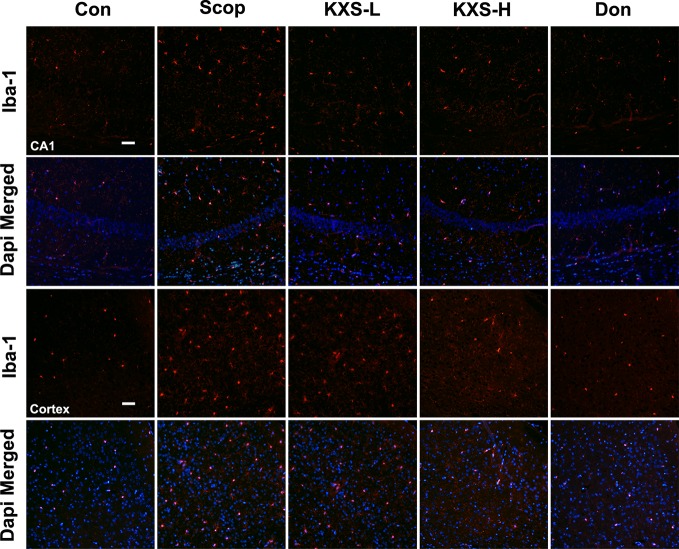
Kai-Xin-San (KXS) attenuates microglia activation in scopolamine (SCOP)-induced mice. Immunofluorescence analysis in the hippocampus (CA1) and cortex. Microglia were stained with anti-Iba-1 (red) and the nuclei were stained with DAPI (blue). Scale bar: 50 μm. Con, control group; SCOP, scopolamine; KXS-L, low-dose Kai-Xin San (1.4 g/kg); KSX-H, high-dose Kai-Xin San (2.8 g/kg); Don, donepezil.